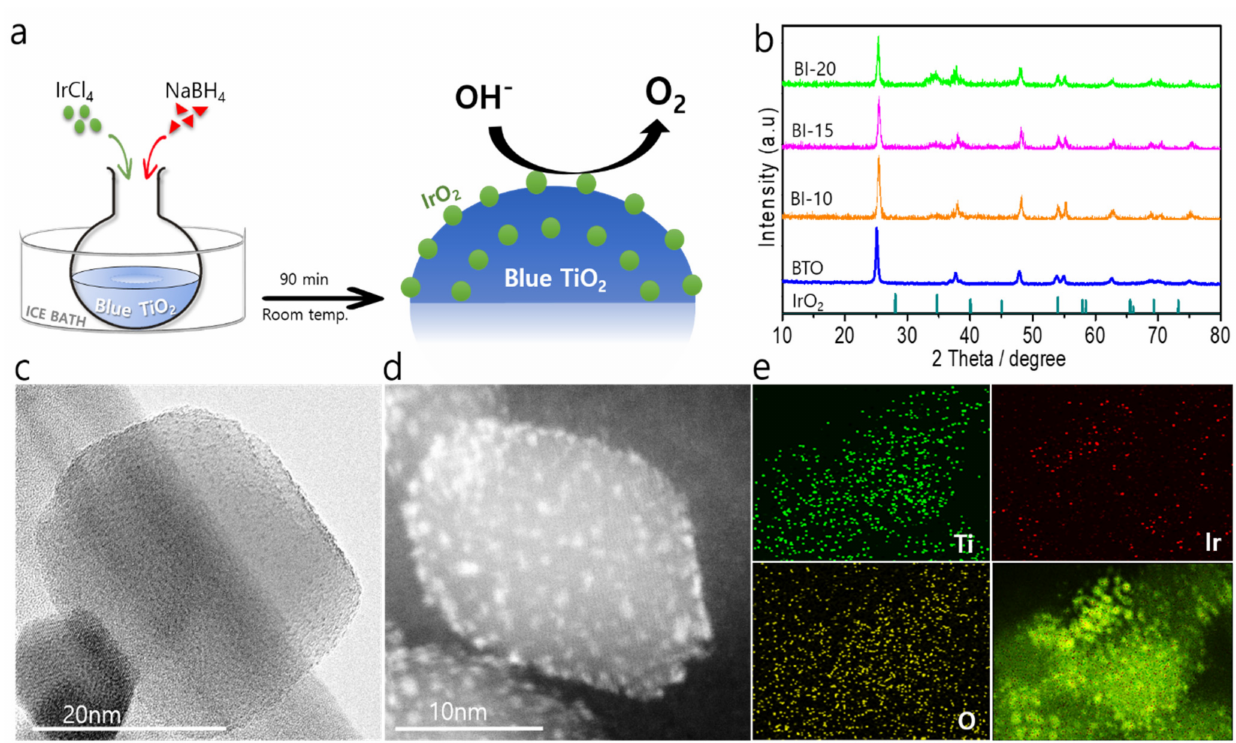
Figure 1. Synthesis and characterization of the IrO 2 − blue TiO 2 NPs. ( a ) Schematic of the synthesis of IrO 2 − Blue TiO 2 NPs in the presence of NaBH 4 solution. ( b ) X-ray diffraction patterns of blue TiO 2 doped with different Ir wt%. ( c ) TEM images and ( d ) HRTEM image of the BI − 15 catalyst. ( e ) EDS elemental maps of the BI − 15 catalyst, showing the distribution of Ti, Ir and